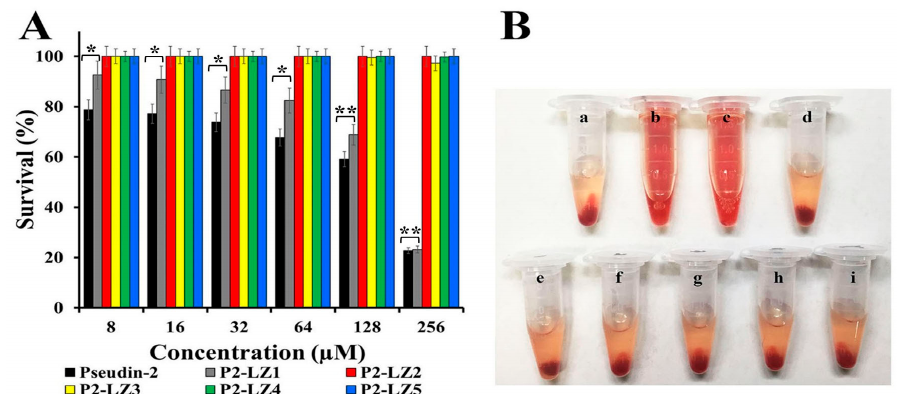
Figure 3. Cytotoxic and hemolytic effects of pseudin-2 and P2-LZ peptides in HaCaT cells ( A ) and mouse erythrocytes ( B ). ( A ) After 24 h incubation of HaCaT cells in the presence of pseudin-2 or P2-LZ peptides, cell proliferation was measured using Alama Blue assays. Data are expressed as the means ± standard deviation from three independent experiments (* p < 0.05, ** p < 0.01). ( B ) Mouse red blood cells were incubated for 4 h in the absence ( a ) or presence of 0.1% Triton X-100 ( b ), melittin (64 µM) ( c ), pseudin-2 (64 µM) ( d ), P2-LZ1 (64 µM) ( e ), P2-LZ2 (64 µM) ( f ), P2-LZ3 (64 µM) ( g ), P2-LZ4 (64 µM) ( h ), or P2-LZ5 (64 µM) ( i ).